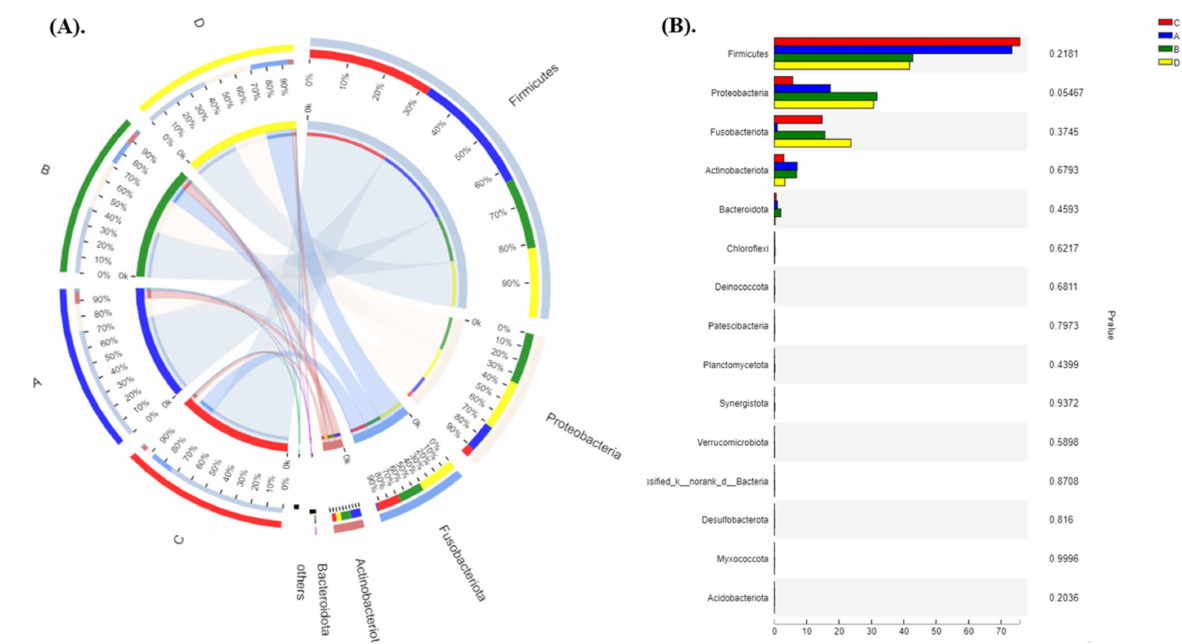
Figure 5. Bacterial compositions of the different communities ( A ) and results of the Kruskal–Wallis test for differences in these microbial taxa ( B ) among each group at the phylum